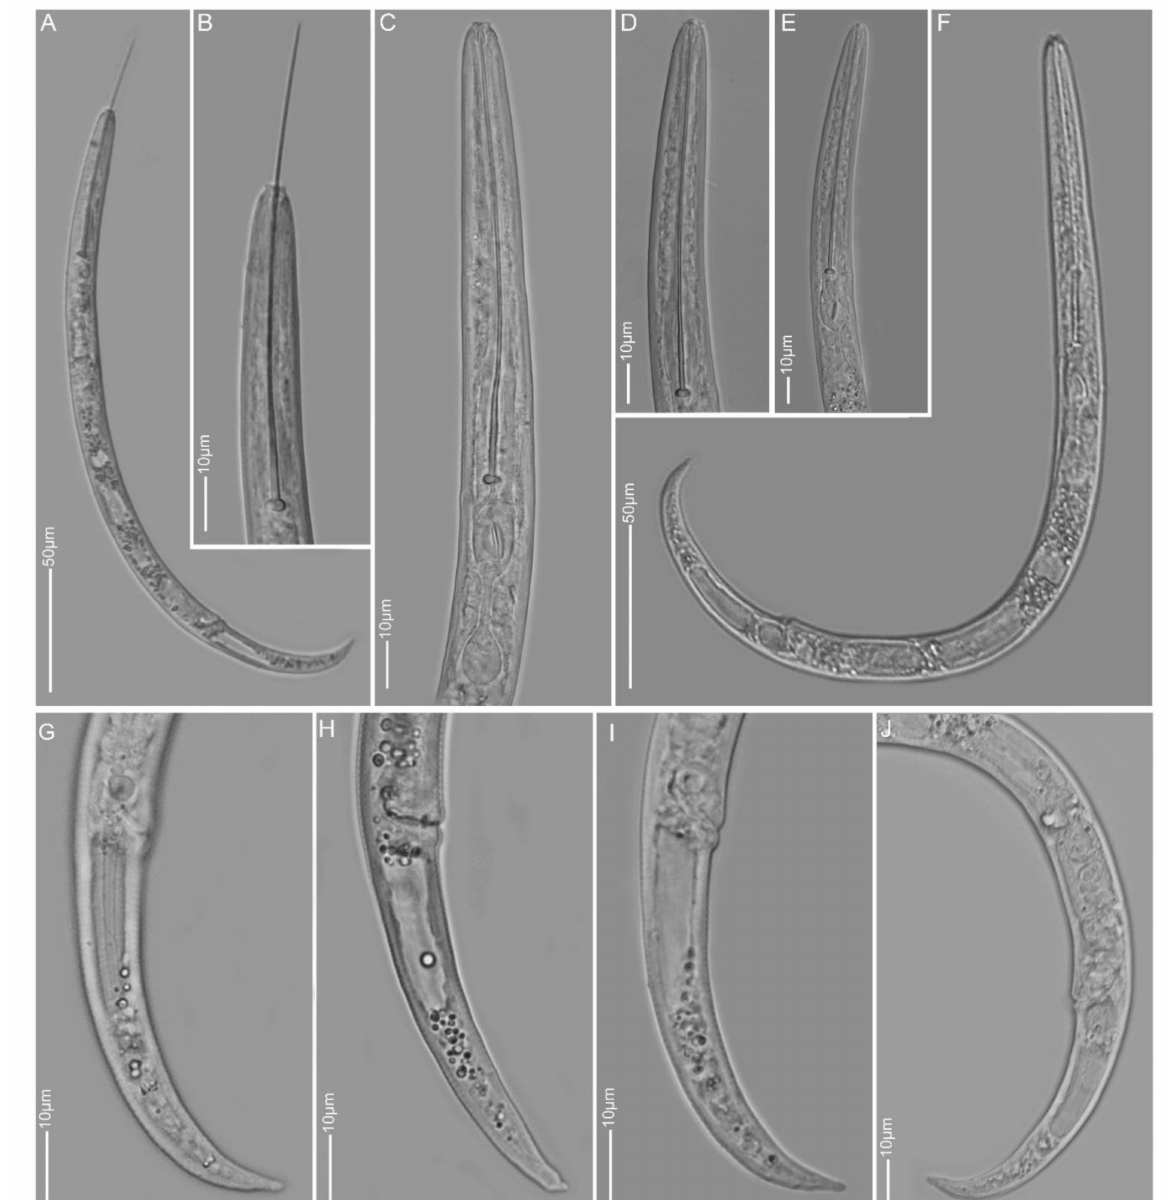
Figure 6. Light microscopy images of Paratylenchus idalimus females from sample BE20: ( A , F ) total body; ( B – E ) anterior region; ( G – J ) tail